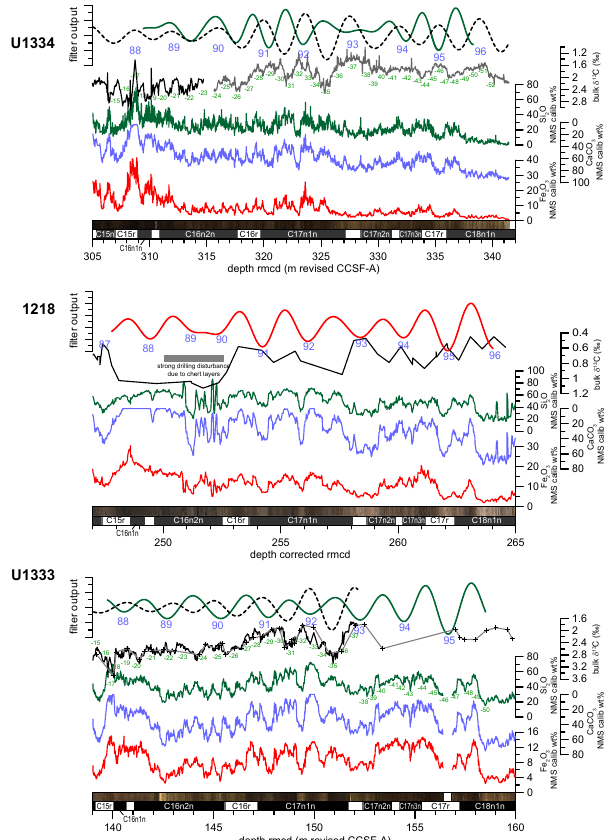
Figure 5. High-resolution XRF core scanning data, bulk and ben- thic stable carbon isotope data, core images, and cyclostratigraphy from Chron C15r to C18n.1n for Sites U1334, 1218, and U1333 in the depth domain. For details see caption of Fig. 2. 405kyr band pass filters: for Site U1334 from Si data (green line; 0 . 26 ± 0 . 075cm − 1 ; 3.85m band in Supplement Fig. S5a) and bulk sta- ble carbon isotopes (dashed black line; 0 . 26 ± 0 . 075cm − 1 ; 3.85m band in Fig. S1a); for Site 1218 from Fe data (0 . 48 ± 0 . 14cm − 1 ; 2.08m band in Fig. S6b); for Site U1333 from Si data (green, 0 . 43 ± 0 . 13cm − 1 ; 2.33m band in Fig. S5c) and bulk stable car- bon isotopes (dashed black line; 0 . 43 ± 0 . 13cm − 1 ; 2.33m band in Supplement Fig. S1b).